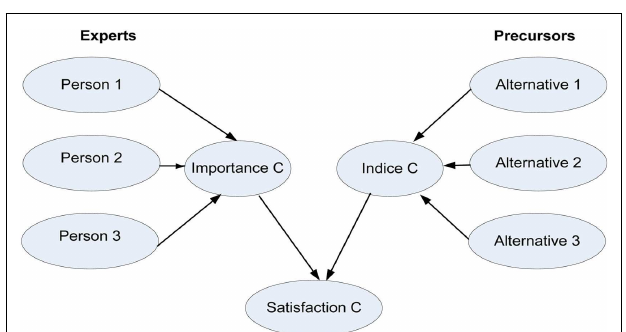
Table 1 | List of expected criteria